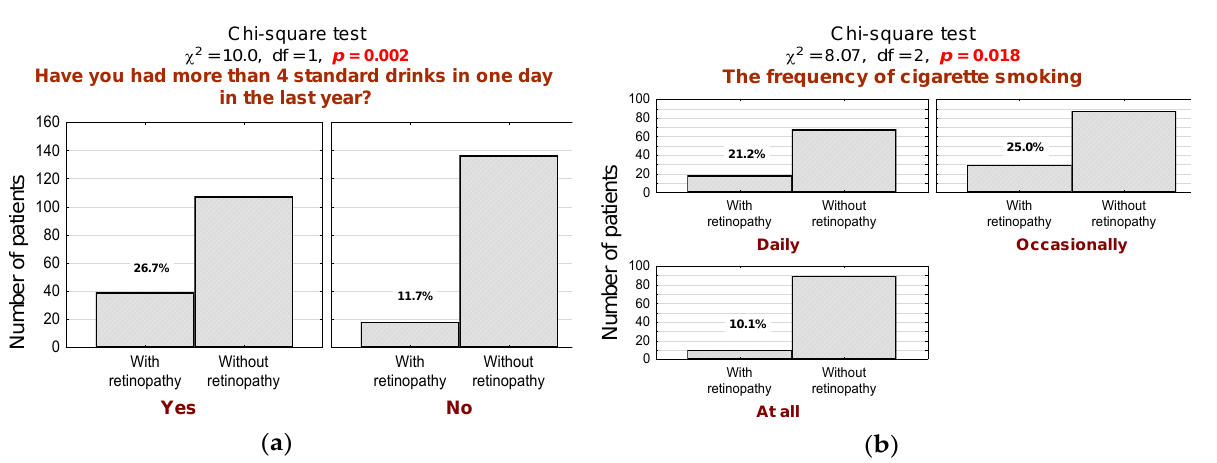
Figure 5. ( a ) Number ( n ) and percentage (%) of patients in groups differing in the presence of diabetic retinopathy and alcohol abuse (more than four standard portions of alcohol in one day in the last period of 12 months), and the result of the independence test; ( b ) number ( n ) and percentage (%) of patients in groups that differ in the presence of diabetic retinopathy and nicotinism, and the test of independence . Chi-square test 2 = 29.4, df = 1, p < 0.001